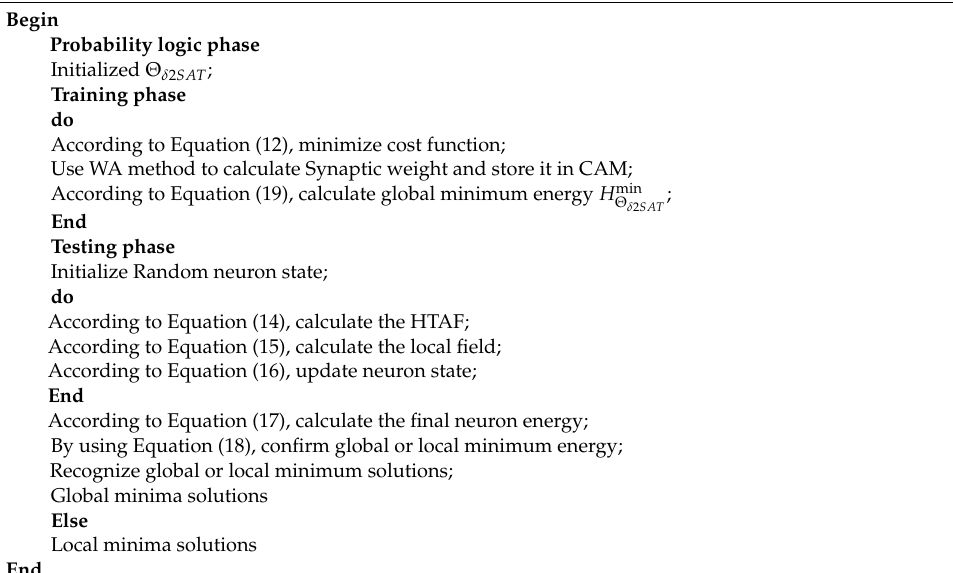
Algorithm 2: Pseudocode of DHNN − δ 2